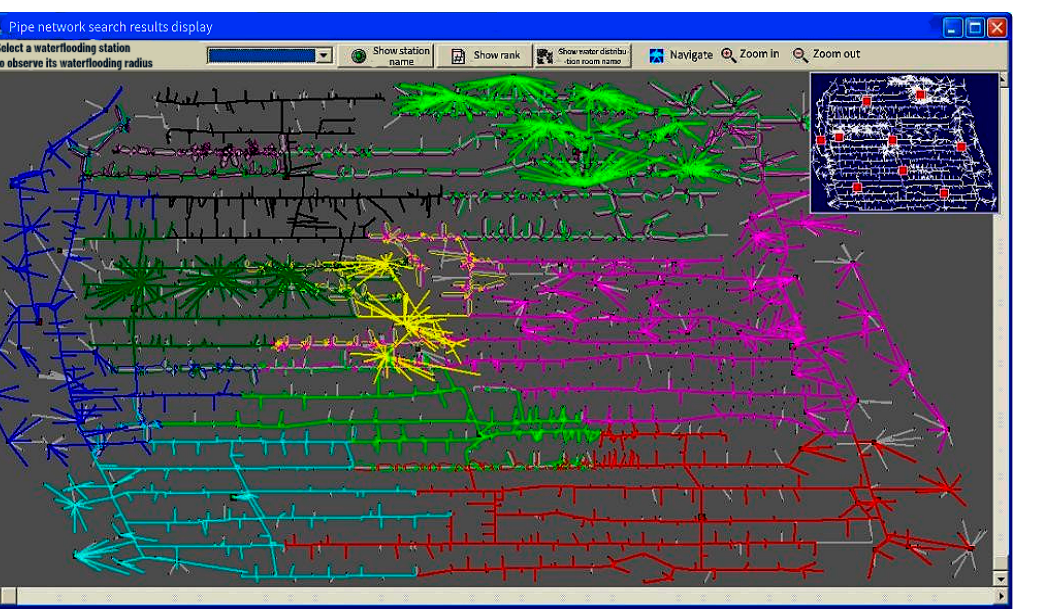
Figure 5. Maximum pressure loss from the station to end well.